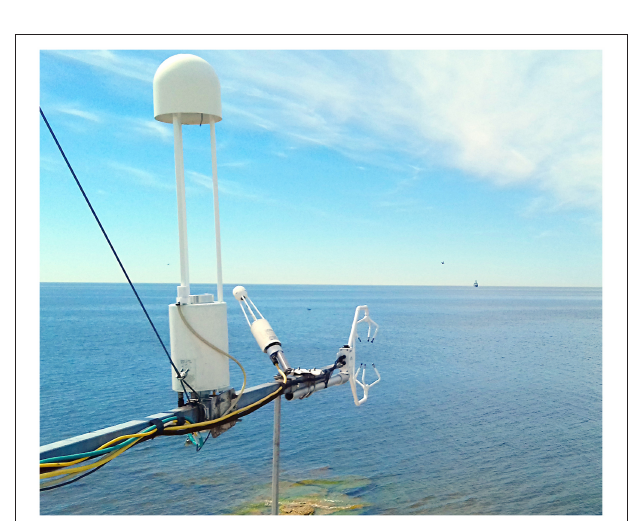
FIGURE 2 | Photograph of the eddy covariance system set-up at level 1 (9 m) at Östergarnsholm station.